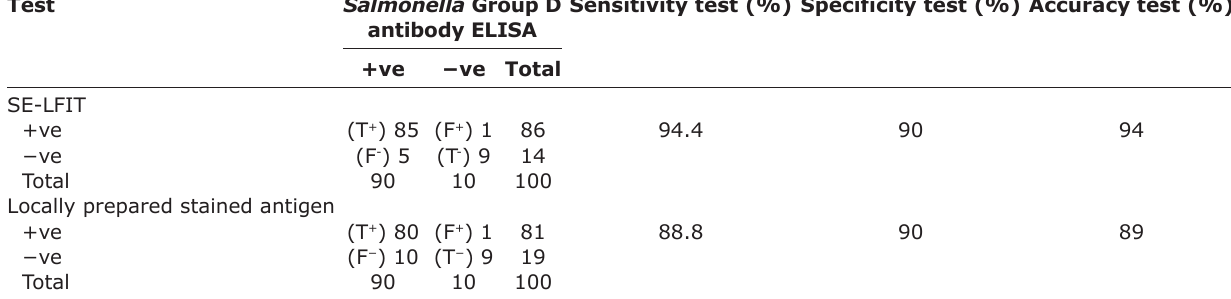
Table-4: Validity test for SE-LFIT and locally prepared stained antigen comparing with Salmonella Group D antibody ELISA.